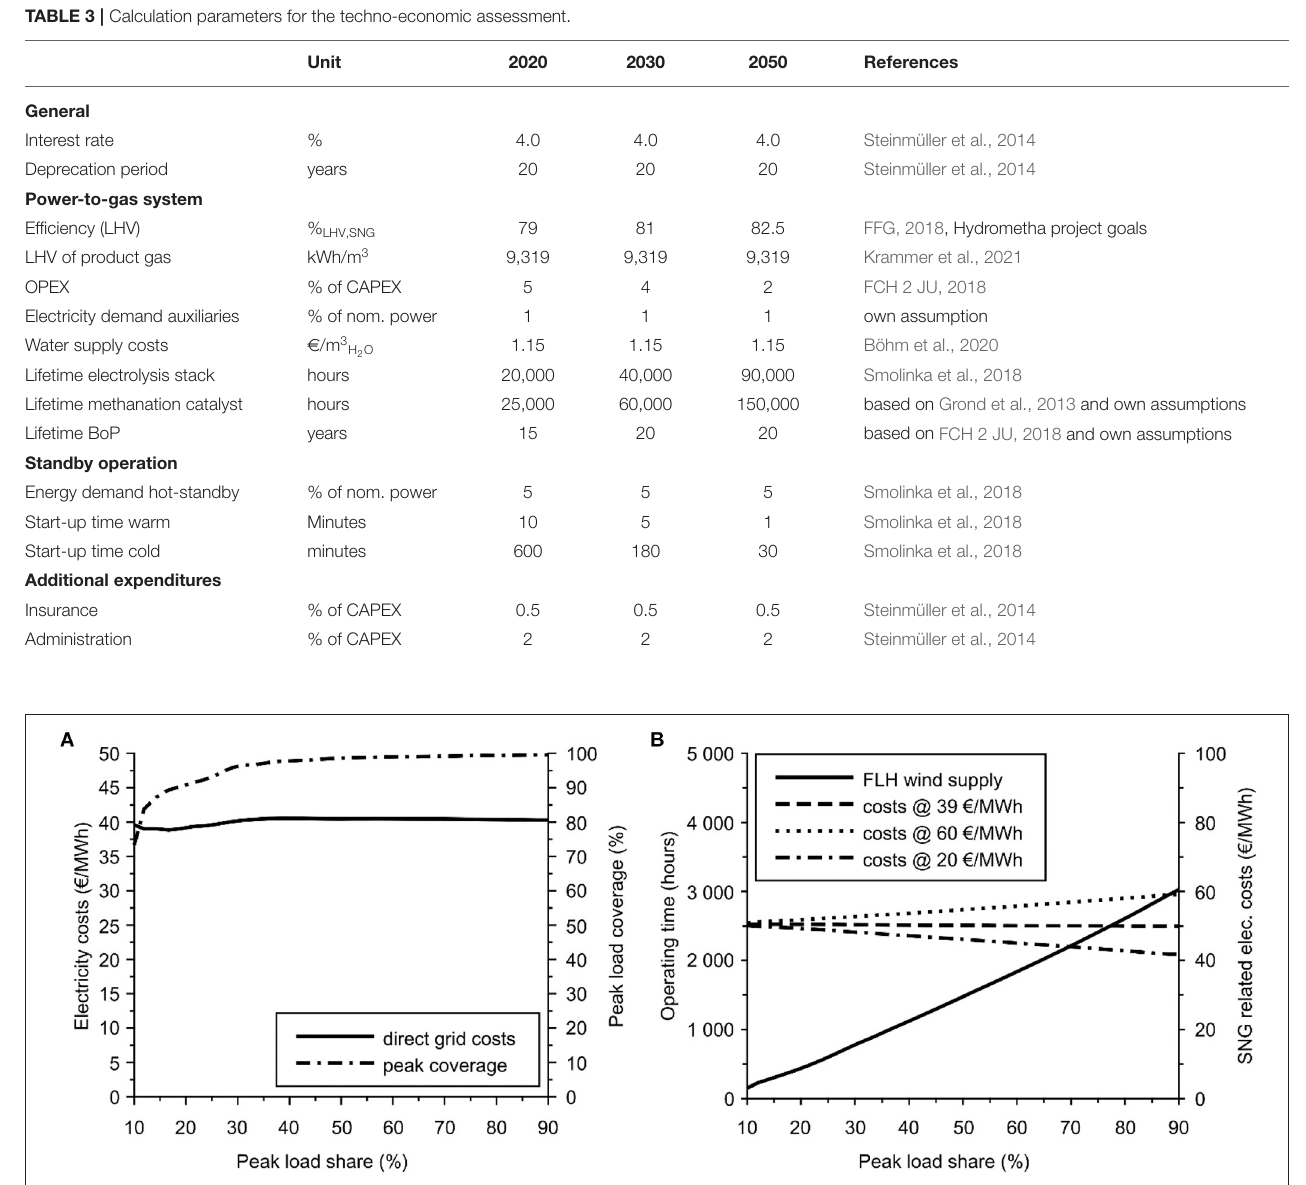
FIGURE 5 | Influence of the electrolyzer to wind park capacity ratio (peak load share) on (A) peak coverage and supply costs and (B) on full load hours and production